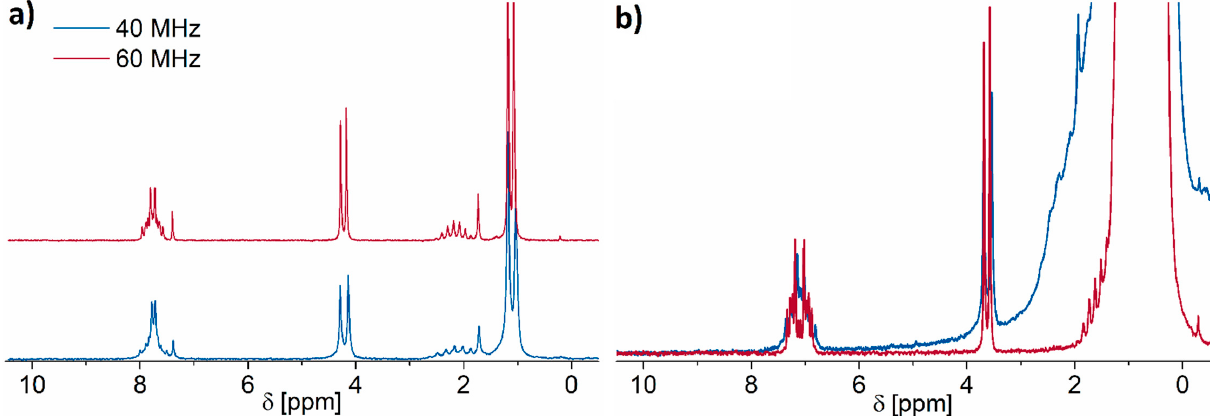
Figure 6. 16.67 mg mL − 1 DIBP solution in ( a ) CDCl 3 and ( b ) n-hexane measured at 40 and 60 MHz. The left graphic shows a stacked plot as the differences between the spectra are hardly visible when displayed superimposed.